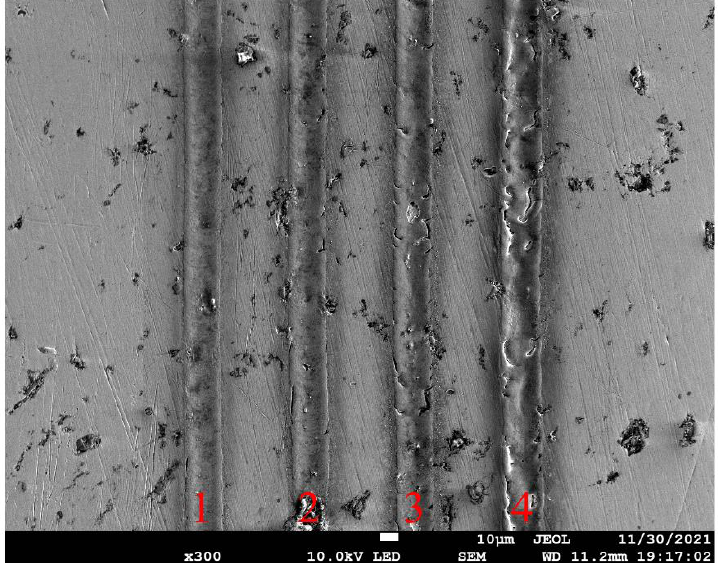
Figure 9. SEM images of ablated grooves on stainless steel sphere under different rotation speeds of C-axis: 1 for 20°/s, 2 for 15°/s, 3 for 10°/s, and 4 for 5°/s.